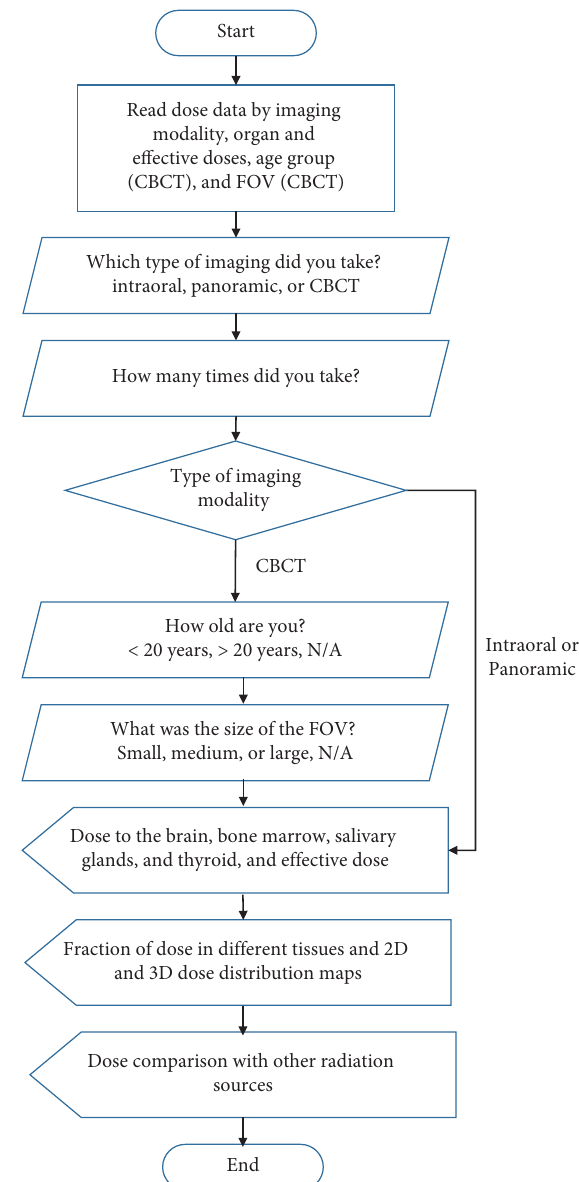
Figure 1: Flowchart of the web application for dental radiation dose calculations and dose